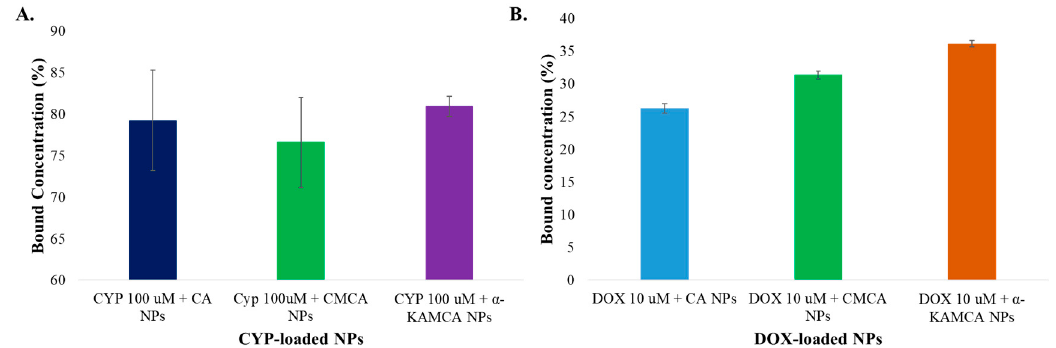
Figure 1. Drug binding affinity for carbonate apatite (CA) nanoparticles (NPs), citrate-modified CA (CMCA) NPs, and α -ketoglutaric acid-modified CA ( α -KAMCA) NPs. ( A ) Estimation of cyclophosphamide (CYP) binding affinity for CA NPs, CMCA NPs, and α -KAMCA NPs. ( B ) Estimation of doxorubicin (DOX) binding affinity for CA NPs, CMCA NPs, and α -KAMCA NPs.